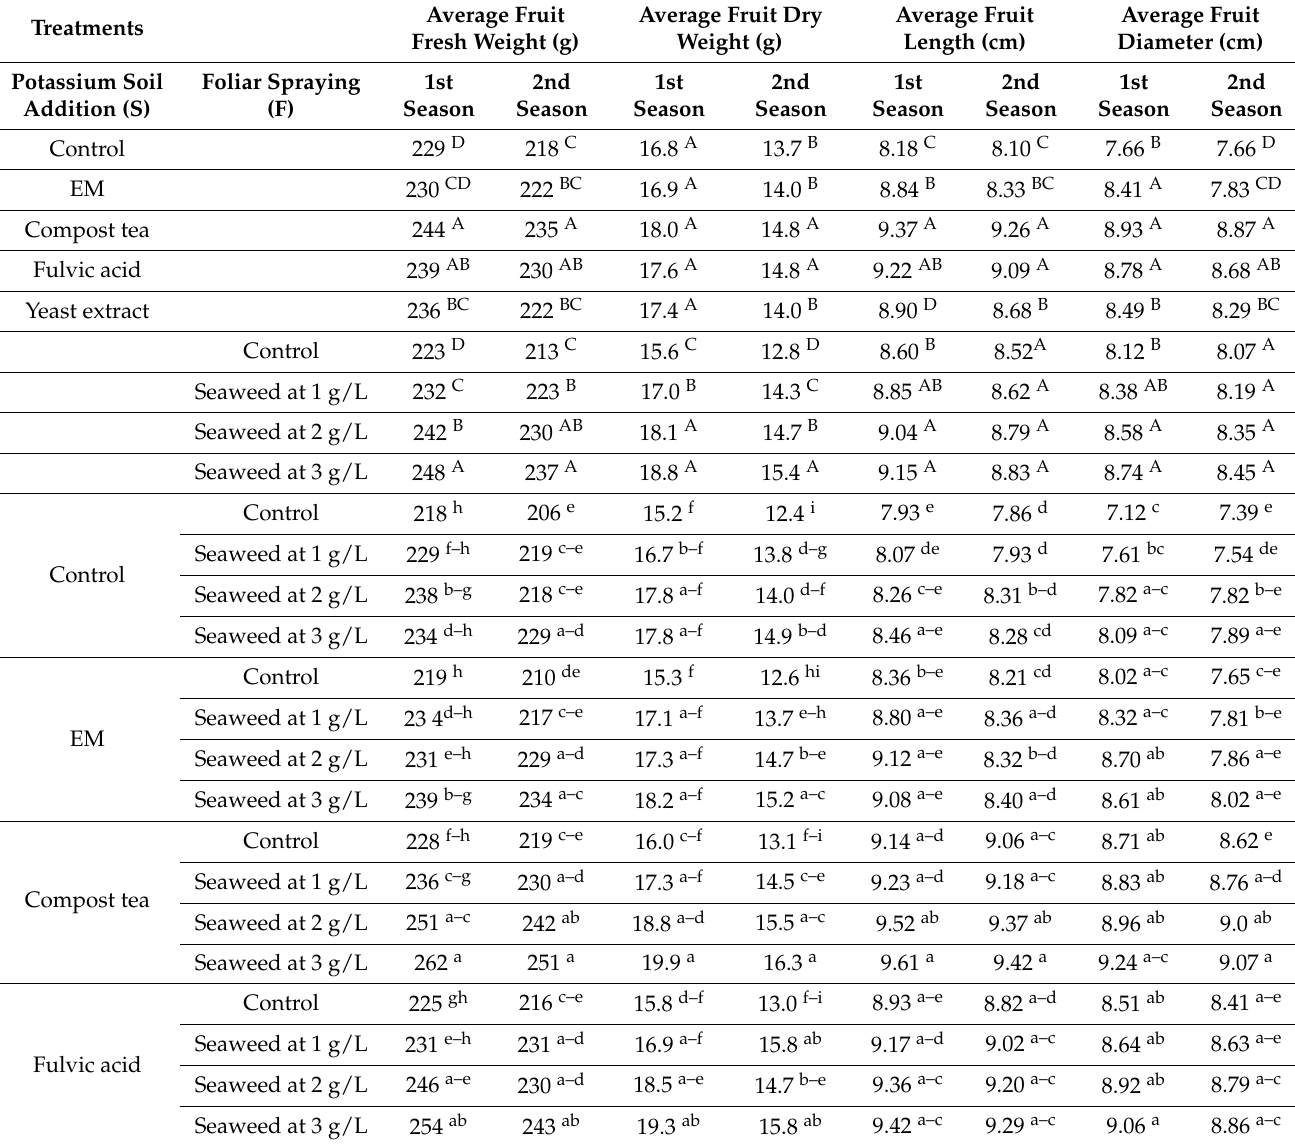
Table 5. Effects of soil addition of EM, compost tea, fulvic acid, yeast extract, and foliar spray with seaweed extract and their combination on the physical quality of the fruit from sweet pepper plants during the 2019/2020 and 2020/2021 seasons. Treatments